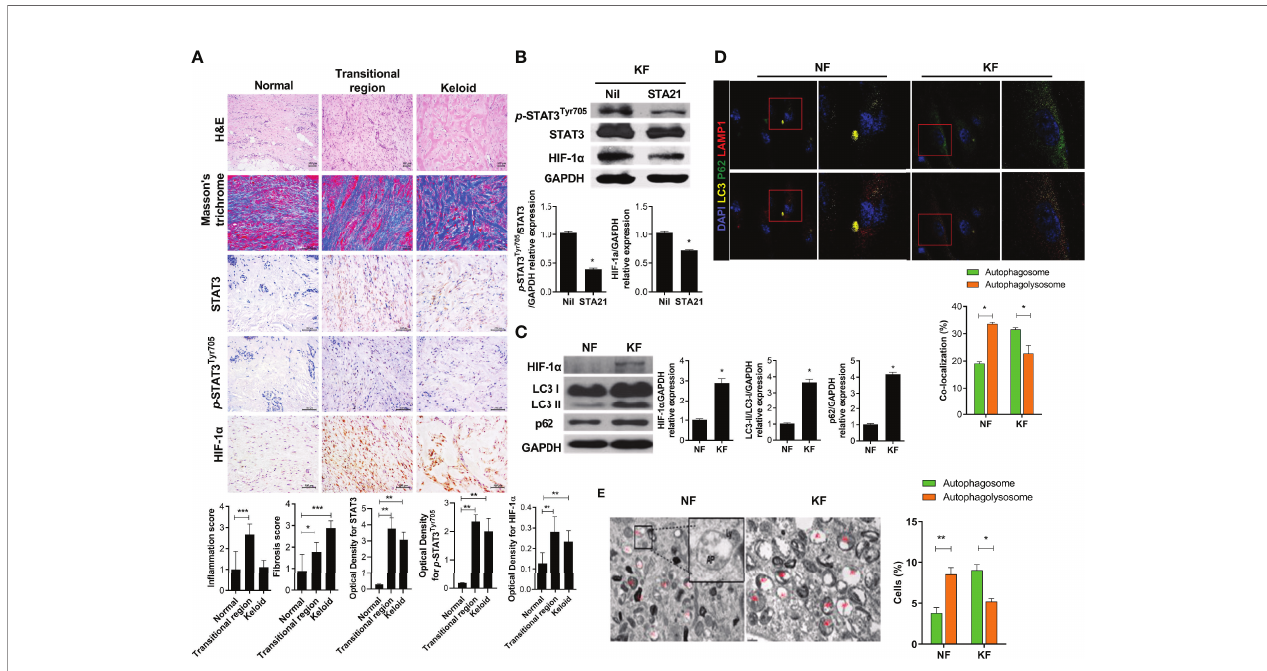
FIGURE 1 | STAT3, HIF-1 a expression in keloid tissue and defective autophagy in KF (A) Keloid tissues were stained with hematoxylin and eosin (H&E) and Masson ’ s trichrome (MT), and evaluated by immunohistochemistry. (B, C) Protein levels of p- STAT3 Tyr705 , STAT3, HIF-1 a , LC3I/II, GAPDH and p62 were analyzed using western blot. (D) Autophagosomes and autophagolysosomes were analyzed by confocal microscopy. Merging of LC3 (yellow), p62 (green), and DAPI (blue) indicates autophagosomes; Merging of LC3 (yellow), LAMP1 (red), and DAPI (blue) indicates autophagolysosomes. (E) Transmission electron micrographs. Bar graph shows data from one of three independent experiments; results are means ± SD of three independent experiments per group (* P < 0.05, ** P < 0.01, *** P <